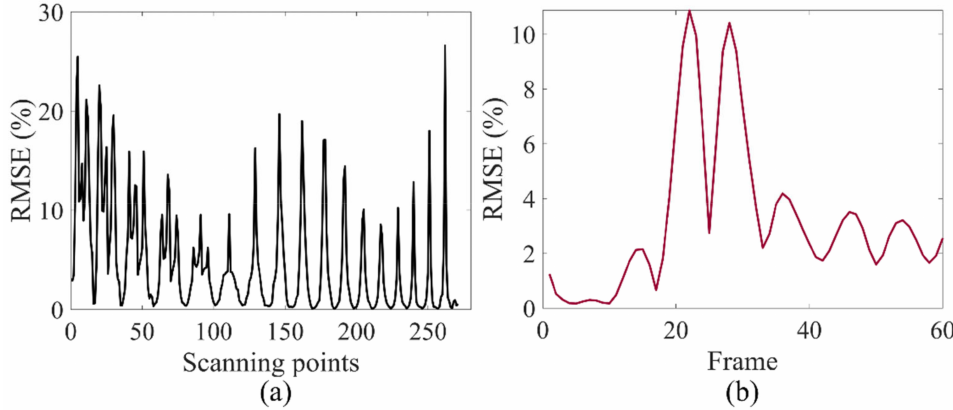
Figure 9. The RMSE of up-sampling process for each scanning points ( a ) and frames ( b ).